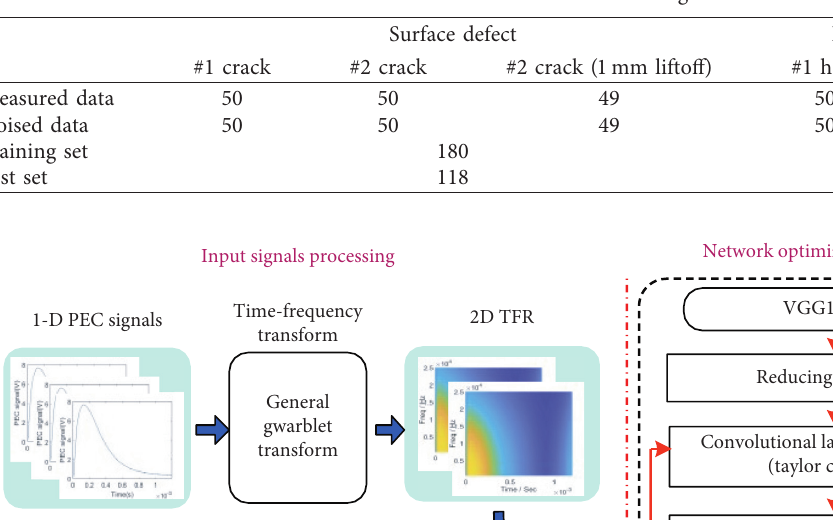
Figure 2: Diagram of three kinds of simulated defects: (a) surface defects; (b) internal defects; (c) hidden defect. Table 1: Information on training and test sets.